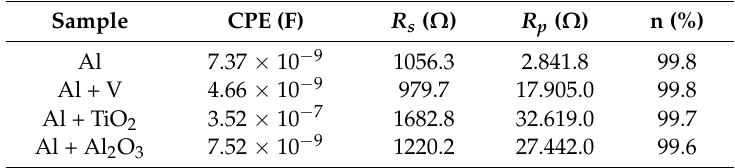
Table 2. Values of the elements of the equivalent electric circuit used to simulate the electrochemical impedance spectroscopy measurements of the samples in the beer electrolyte. CPE—constant phase element. R s —solution/electrolyte resistance. R p —polarization resistance. n—circuit fitting